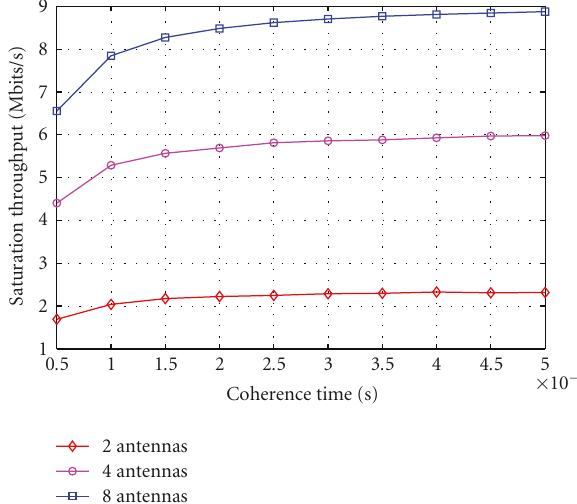
Figure 13: Saturation throughput (Mbits/s) for di ff erent coherence time, α = 2.